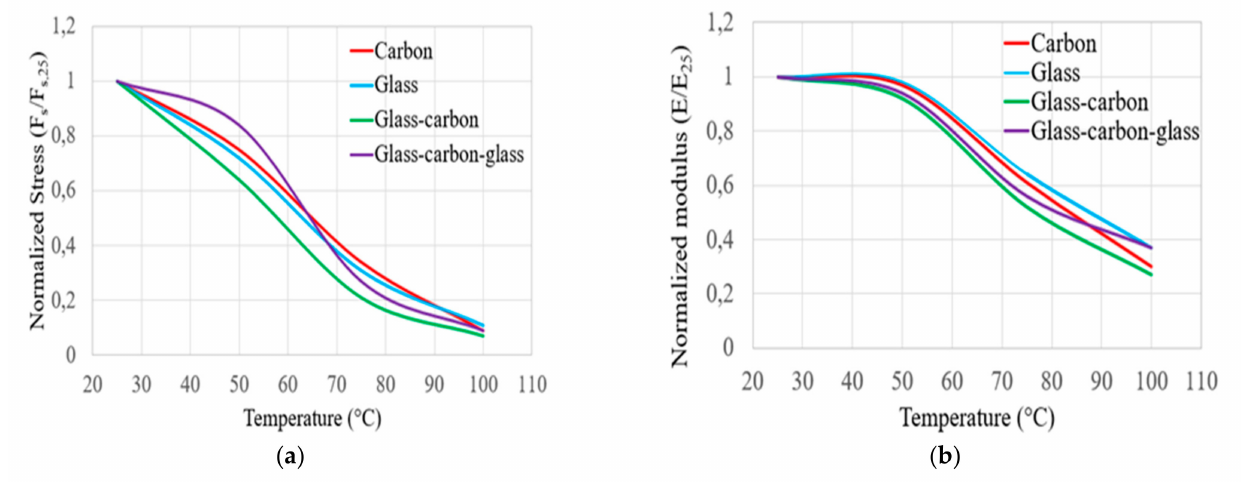
Figure 4. Comparison of the normalised flexural stress ( a ) and modulus ( b ) of hybrid and non-hybrid bidirectional composite